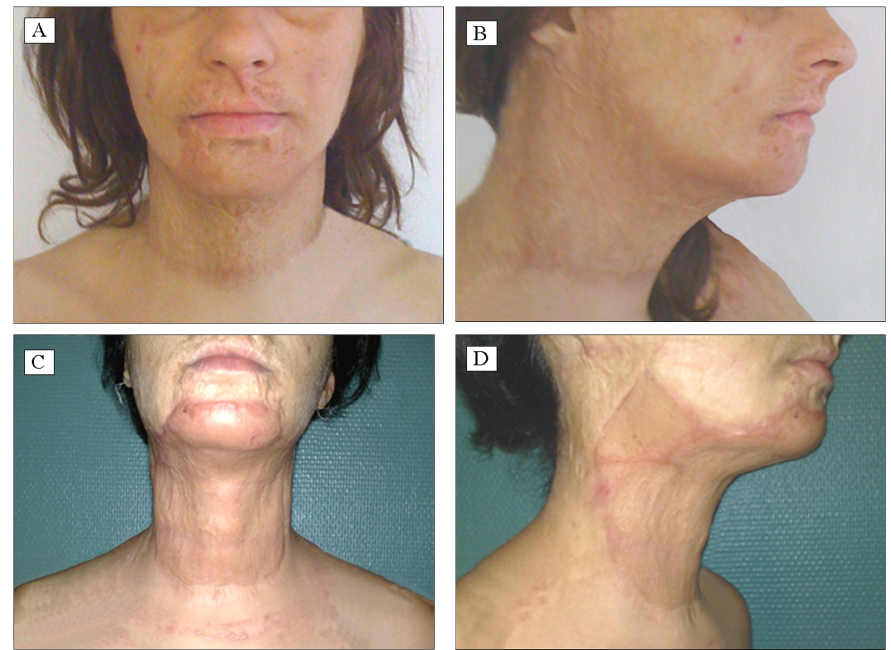
Figure 3. Case 3. A 21-year-old girl that suffered in her childhood, ten years ago a thermal burn by hot liquid IIndb–IIIrd degree on 25% burned surface (neck, anterior thorax, upper limbs): ( A ) Aspect of the neck scar prior to Integra reconstruction—frontal view; ( B ) aspect of the neck scar prior to Integra reconstruction—lateral view ( C ) neck skin reconstruction with Integra, 9 months later-frontal view ( D ) neck skin reconstruction with Integra, after 9 months—lateral